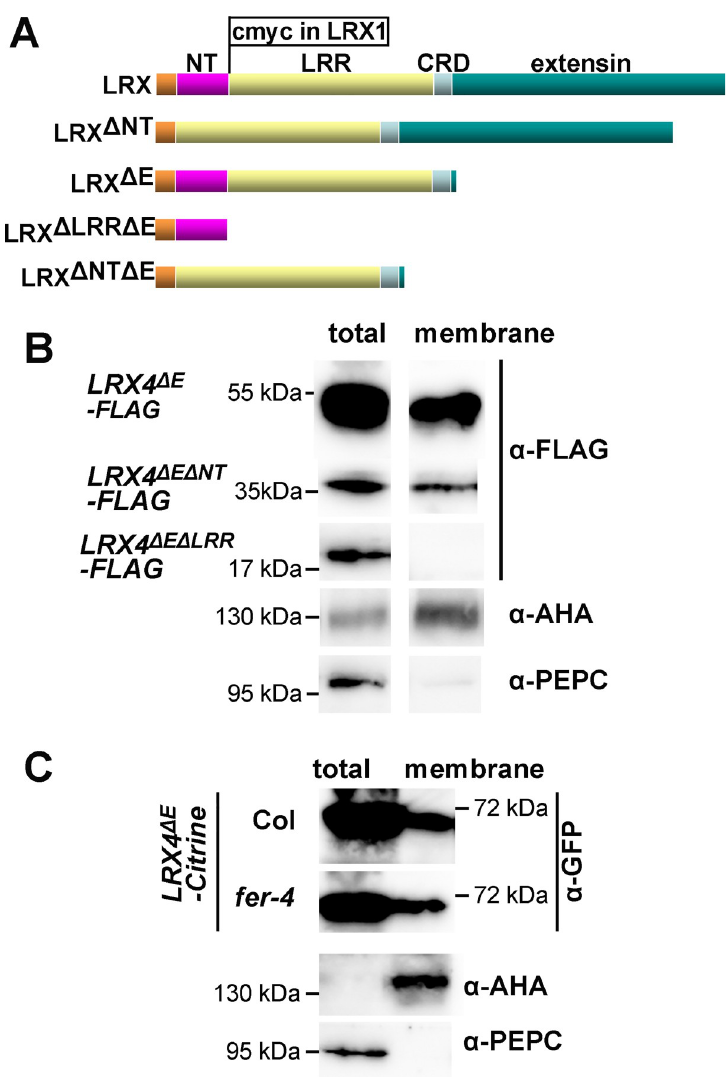
Fig 1. Membrane association of variants of LRX proteins. (A) LRX proteins consist of a signal peptide for export of the protein (light brown), an NT-terminal domain (purple) of unknown function, an leucine-rich repeat (LRR) domain (yellow), a Cys-rich hinge region (CRD), and a C-terminal extensin domain (green), with Ser-Hypn repeats typical of hydroxyproline-rich glycoproteins, for insolubilization of the protein in the cell wall. The different deletion constructs used in this study are listed, with” Δ ” indicating deleted domains. In the LRX1 construct, a cMyc tag was introduced between the NT- and the LRR-domain, which does not interfere with protein function and allows for immuno-detection of LRX1. (B and C) Immunoblots of total extracts (left) and membrane fractions (right) of transgenic Arabidopsis expressing LRX4 constructs as indicated. AHAs are transmembrane proteins used as plasma membrane marker proteins. PEPC is the cytosolic PEP carboxylase used as a cytosolic marker. consists of eleven members, which can be grouped according to three specific expression pat- terns. LRX1/2 are predominantly expressed in root hairs, LRX3/4/5 in the main root and the shoot, and LRX8/9/10/11 in pollen. Mutations in these genes cause cell wall perturbation and cell growth defects in the respective cell types [33,35,36,37,38,39]. lrx1 mutants develop deformed root hairs that are swollen, branched, and frequently burst [33]. This phenotype is strongly aggravated in the lrx1 lrx2 double mutant that is virtually root hair-less [35]. The lrx345 triple mutant shows defects in vacuole development, monitoring of cell wall